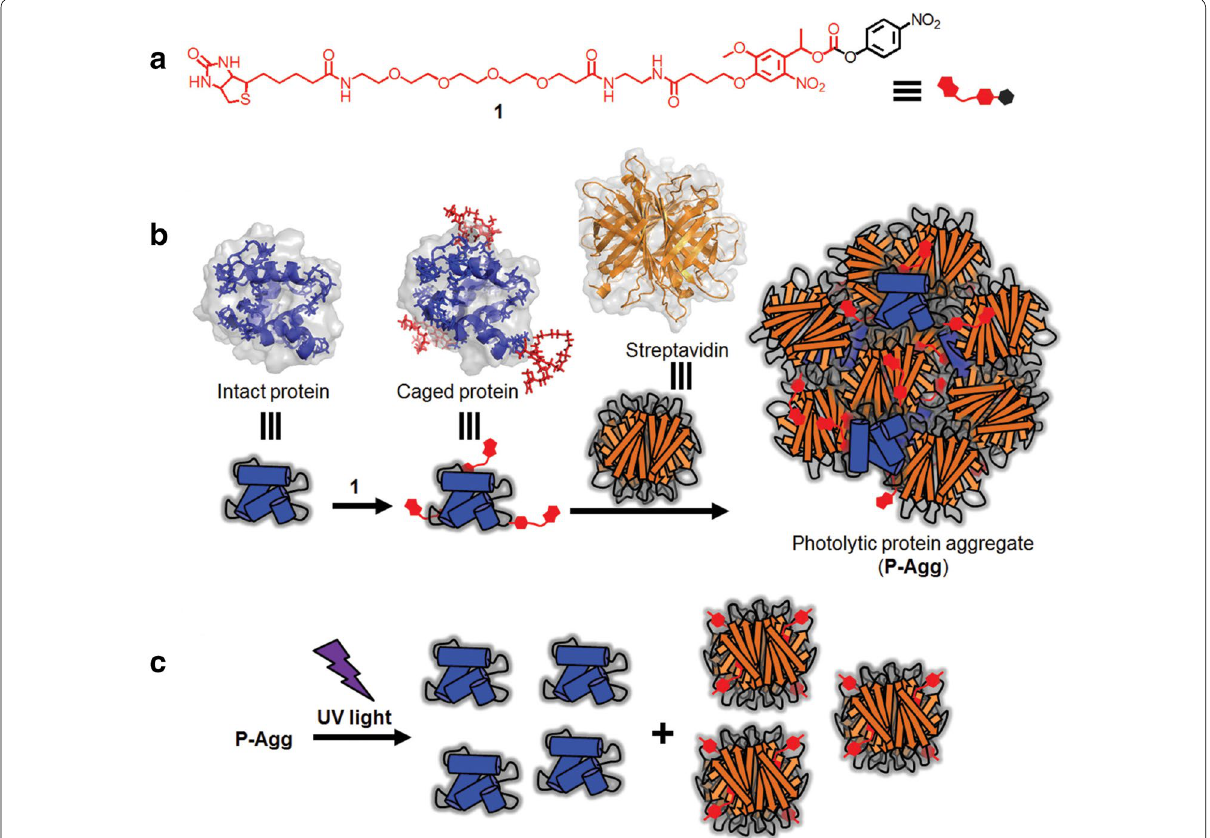
Fig. 4 Schematic illustration of photolytic P-Aggs formation and light-induced release of active proteins. a The chemical structure of BCR 1 consist- ing of a biotinylated photo-cleavable protection group ( red ) and an amino-reactive group ( black ). b Schemes of P-Aggs formation. c Protein photo- liberation from P-Aggs (Figure reproduced with permission from: Ref. [62]. Copyright (2016) with permission from John Wiley and